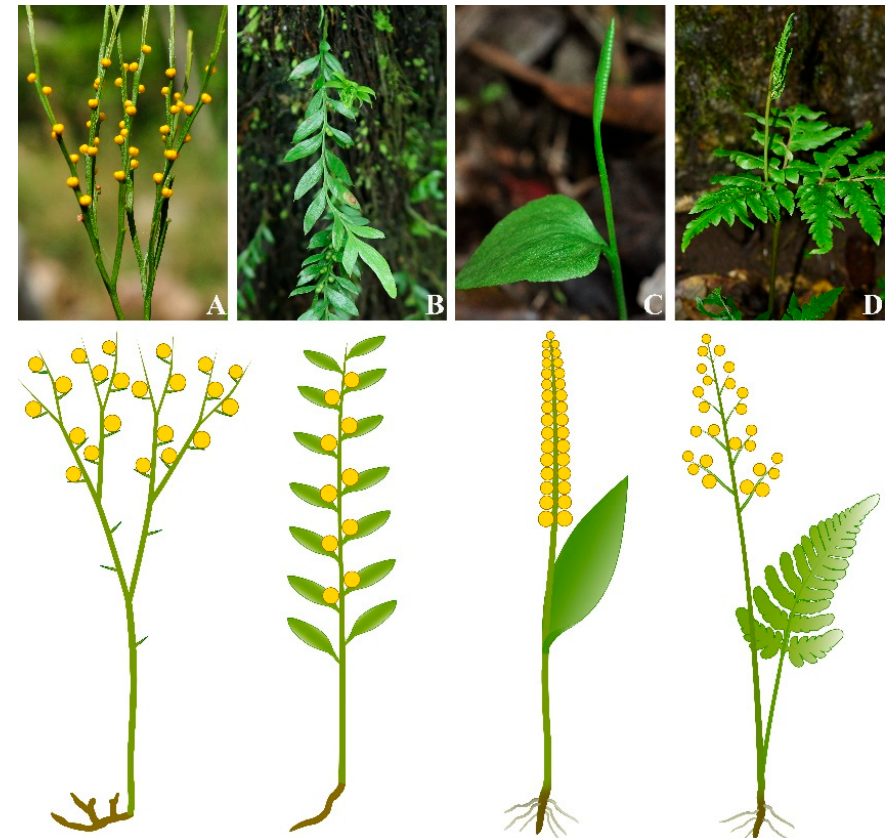
Figure 1. The distinct morphologies of whisk ferns and ophioglossoid ferns. ( A , B ), the whisk ferns, Psilotum nudum ( A ) and Tmesipteris tannensis ( B ) are characterized by the lack of roots, the reduction of leaves, the leaf-like appendages and the absorptive rhizoids. ( C , D ), the ophioglossoid ferns, Ophioglossum vulgatum ( C ) and Botrychium japonicum ( D ), are characterized by simple or pinnatifid leaves and a reduced root system.